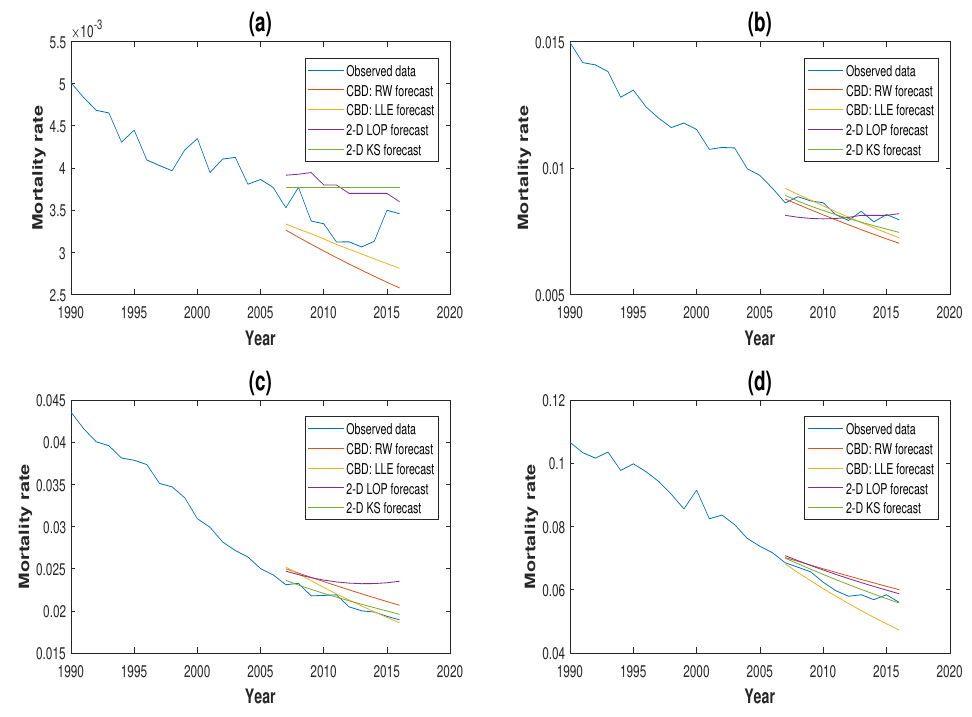
Figure 7. Ten-year-ahead forecast from 2007–2016 for GB males aged ( a ) 50, ( b ) 60, ( c ) 70 and ( d ) 80 based on mortality data since